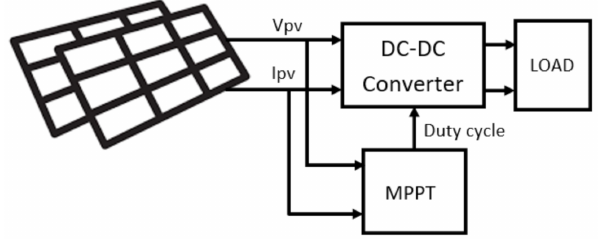
Figure 1. A typical PV Power